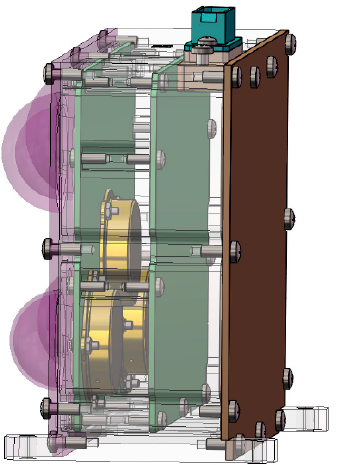
Figure 4. The three-dimensional picture of the dose detector.